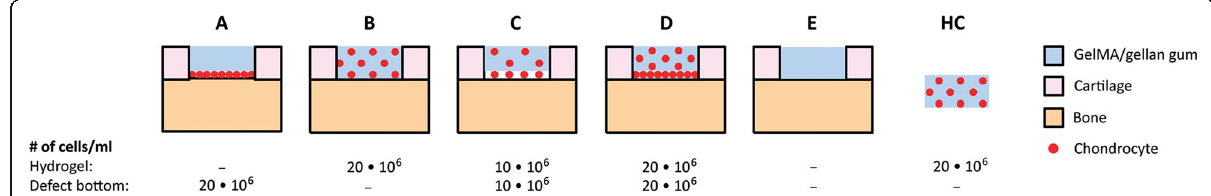
Fig. 6 Schematic cross-sectional overview of the different Chondrocyte filled conditions. Reproduced with permission [96]. Copyright (2018), Springer